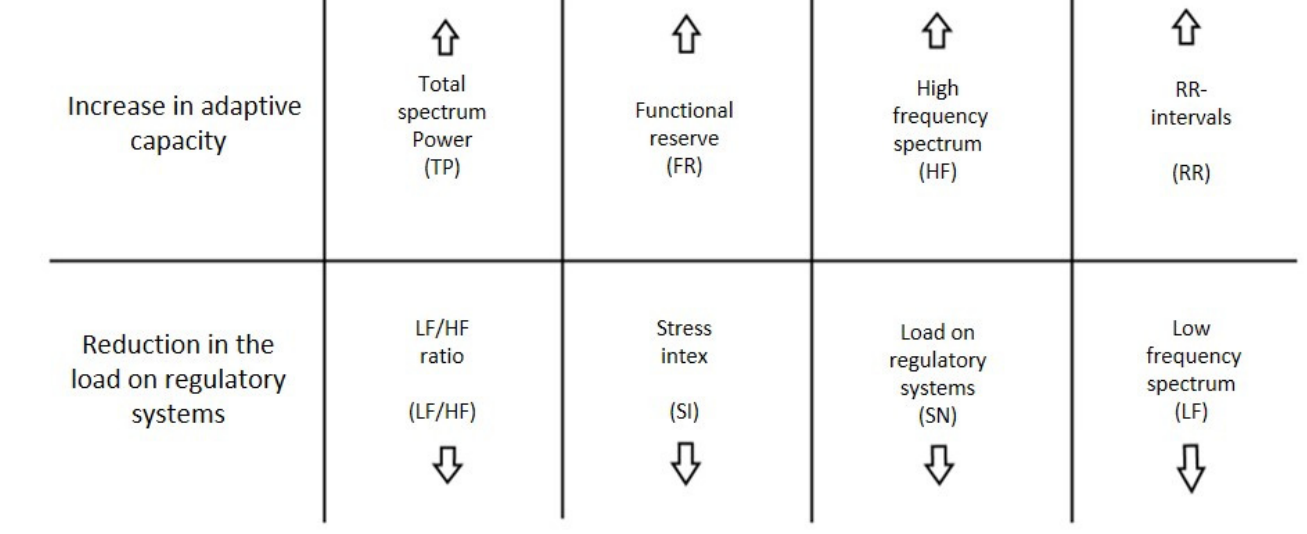
Figure 19. State optimization markers depending on the functional effect.